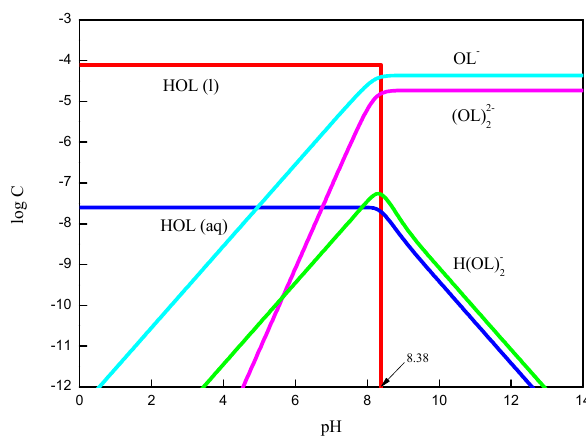
Figure 14. Species distribution diagram of NaOL as a function of pH (NaOL: 4 × 10 − 4 mol/L).